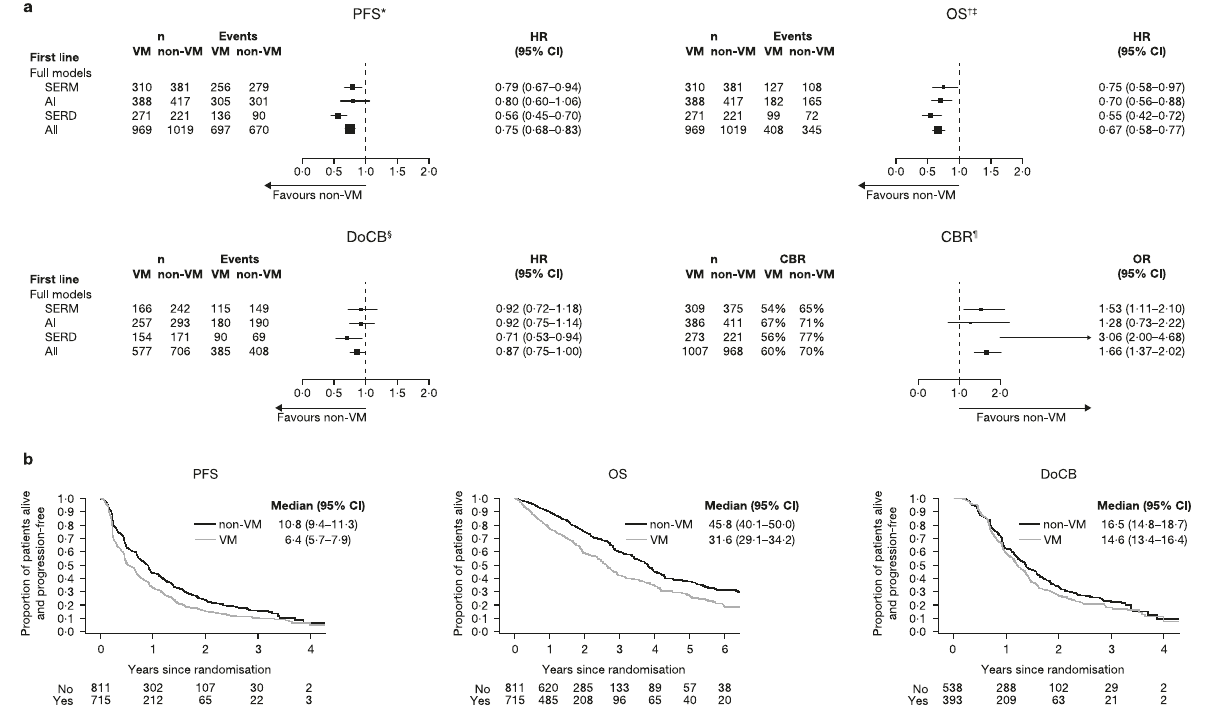
Fig. 2 Clinical outcome measures for VM versus non-VM in the fi rst-line setting. a Forest plots of PFS, OS, DoCB and CBR. * Random effect for trial were fi tted to AI and all data. † Fixed effects for trial were fi tted in all models. ‡ OS data for Study 0027 are based on aggregated mature survival data. § Fixed effect for trial was fi tted in all models. ¶ Fixed-effect model was fi tted to the SERD, SERM and all data; random effects for trial were included in the models for AI. b Projected probability of PFS, OS and DoCB. Kaplan – Meier curves are for ET combined and do not include FALCON data. Median (95% CI) PFS/OS/DoCB in months. AI aromatase inhibitor, CBR clinical bene fi t rate, DoCB duration of clinical bene fi t, HR hazard ratio, non-VM non-visceral metastases, n number of patients, OS overall survival, PFS progression-free survival, SERD selective estrogen receptor degrader, SERM selective estrogen receptor modulator, VM visceral metastases. Statistics for full models: PFS: SERM: p = 0·008, heterogeneity test p = 0·26; AI: p = 0·122, heterogeneity test p < 0·05; SERD: p < 0·001, heterogeneity test p = 0·40; All: p < 0·001, heterogeneity test p < 0·05. OS: SERM: p = 0·031, heterogeneity test p = 0·21; AI: p = 0·002, heterogeneity test p = 0·24; SERD: p < 0·001, heterogeneity test p = 0·68; All: p < 0·001, heterogeneity test p = 0·24. DoCB: SERM: p = 0·527, heterogeneity test p = 0·57; AI: p = 0·446, heterogeneity test p = 0·33; SERD: p = 0·018, heterogeneity test p = 0·13; All: p = 0·04, heterogeneity test p = 0·28.CBR: SERM: p = 0·009, heterogeneity test p = 0·19, AI: p = 0·388, heterogeneity test p = 0·02; SERD: p < 0·001, heterogeneity test p = 0·78; All: p < 0·001, heterogeneity test p =